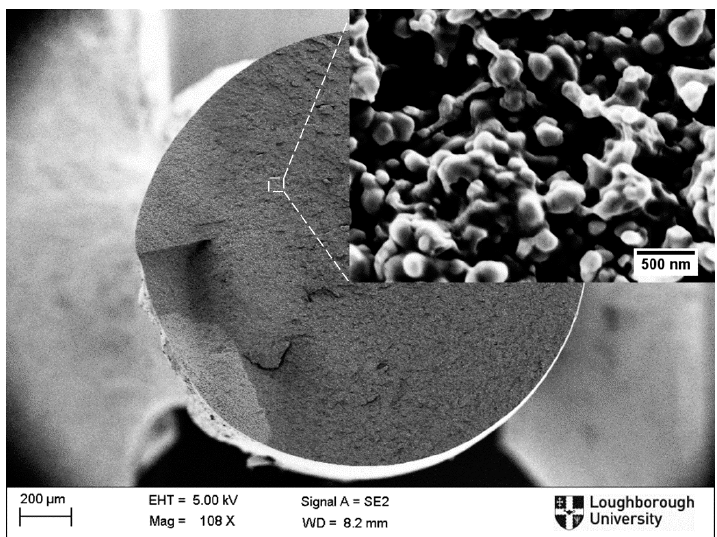
Figure 1. Scanning electron micrograph of the ceramic infill nanoparticles within an ABS matrix.